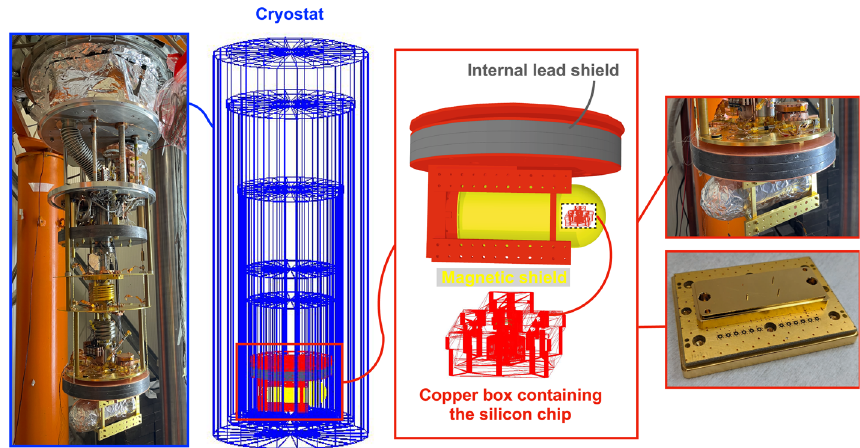
Fig. 6 Experimental setup as implemented in the simulation. The chip inside the copper box is the only active volume. The copper box, holder and magnetic shield were imported from the CAD file, while for the dilution refrigerator we implemented a simplified